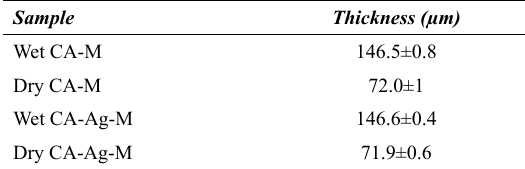
Figure 2. SEM images from brilliant surface (A), opaque surface (B) and cross section (C) of the CA-M. SEM images from brilliant surface (D), opaque surface (E) and cross section (F) of the CA-Ag-M. Table 1. Thickness of the studied